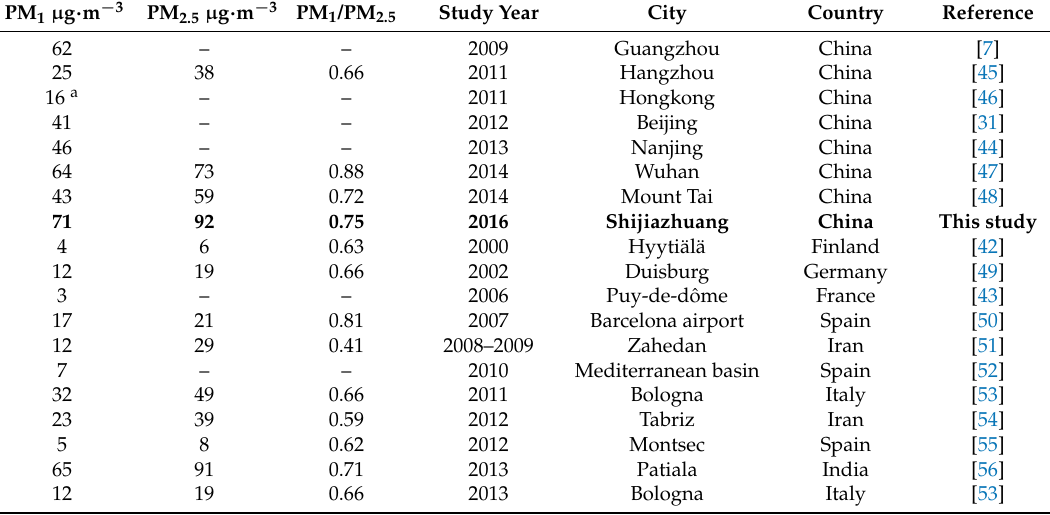
Table 1. Average mass concentration of PM 1 , PM 2.5 , and PM 1 /PM 2.5 ratio in